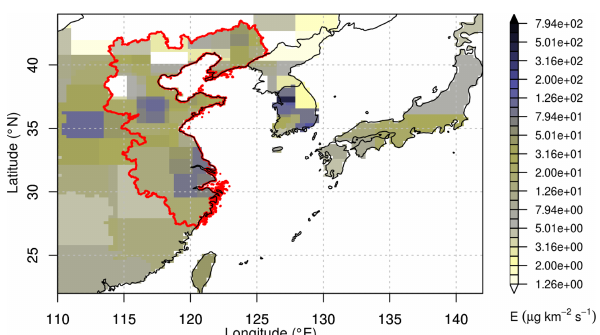
Figure 6. SF 6 western Europe emission estimates (Ggyr − 1 ) from the UNFCCC inventory (black); InTEM inversion (2013–2018, blue, seven sites: MHD, JFJ, CMN, TAC, RGL, HFD, BSD); EBRIS (2013–2018, orange, 4 sites: MHD, TAC, JFJ, CMN); and FLITS (2013–2018, green, four sites: MHD, TAC, JFJ, CMN). The uncer- tainty bars are ± 1 SD.